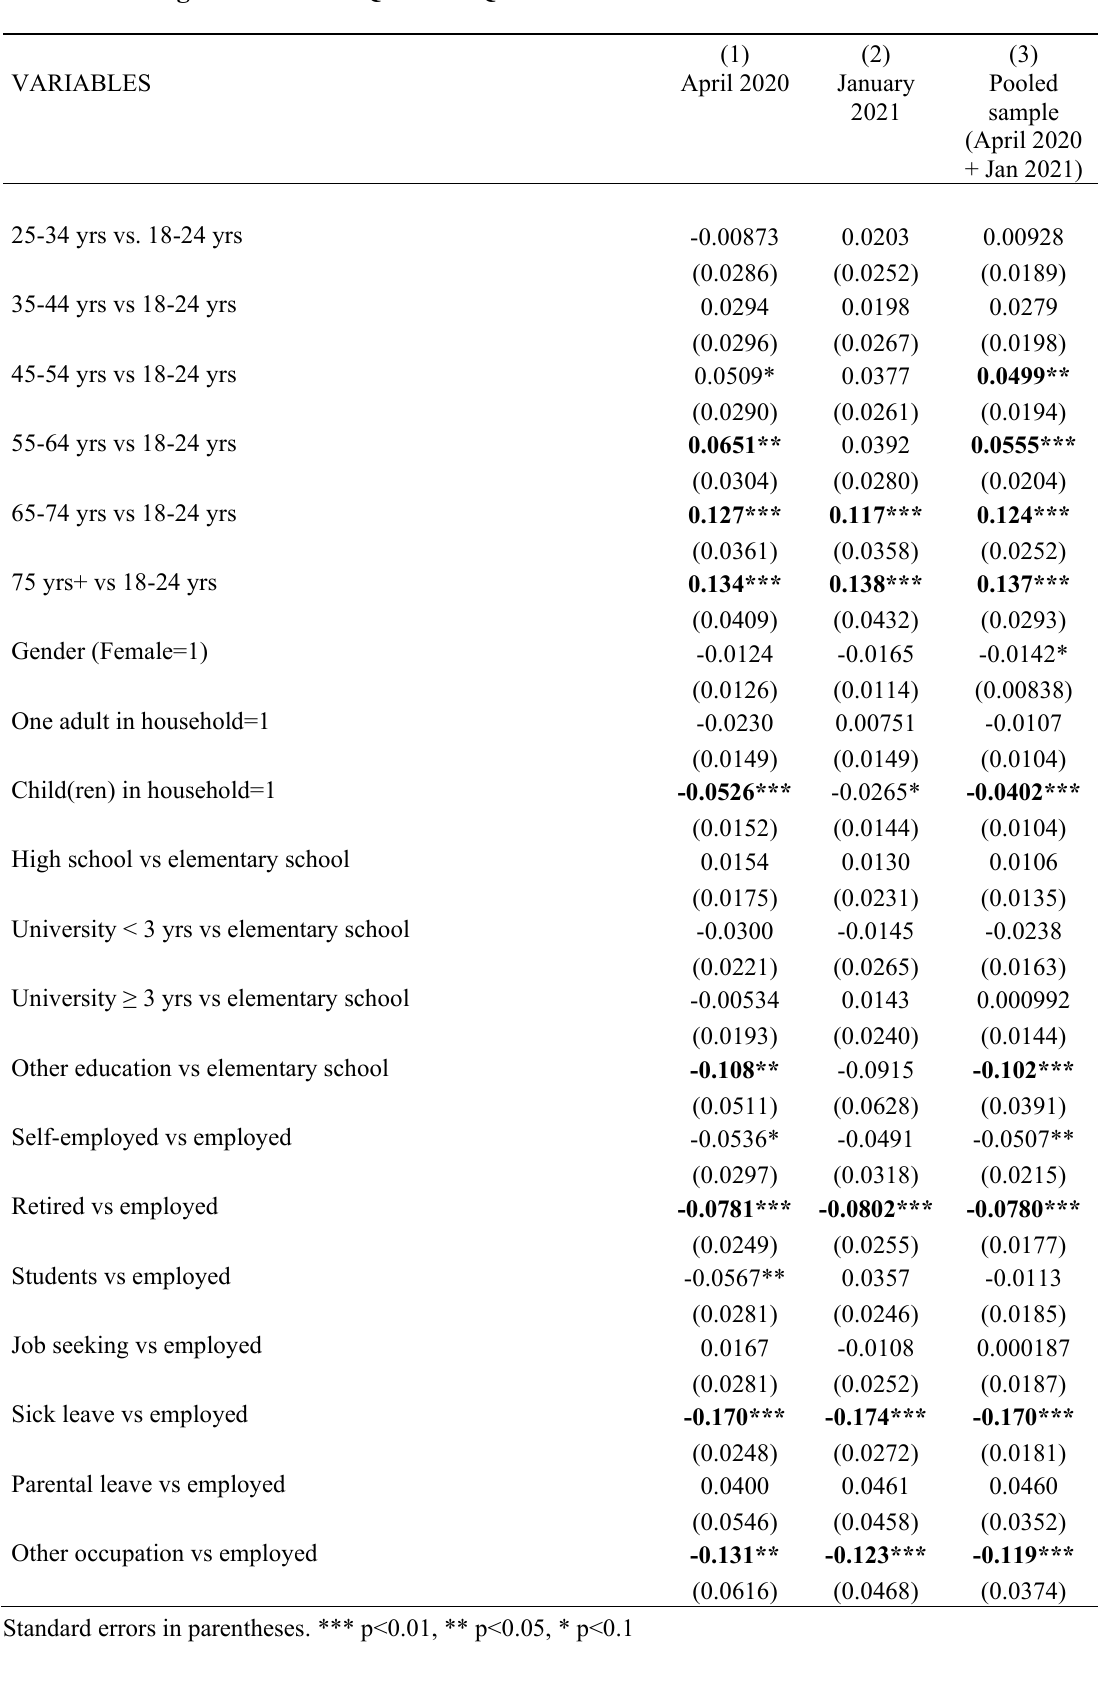
Table A1: Regressions of HRQoL on EQ-5D-5L